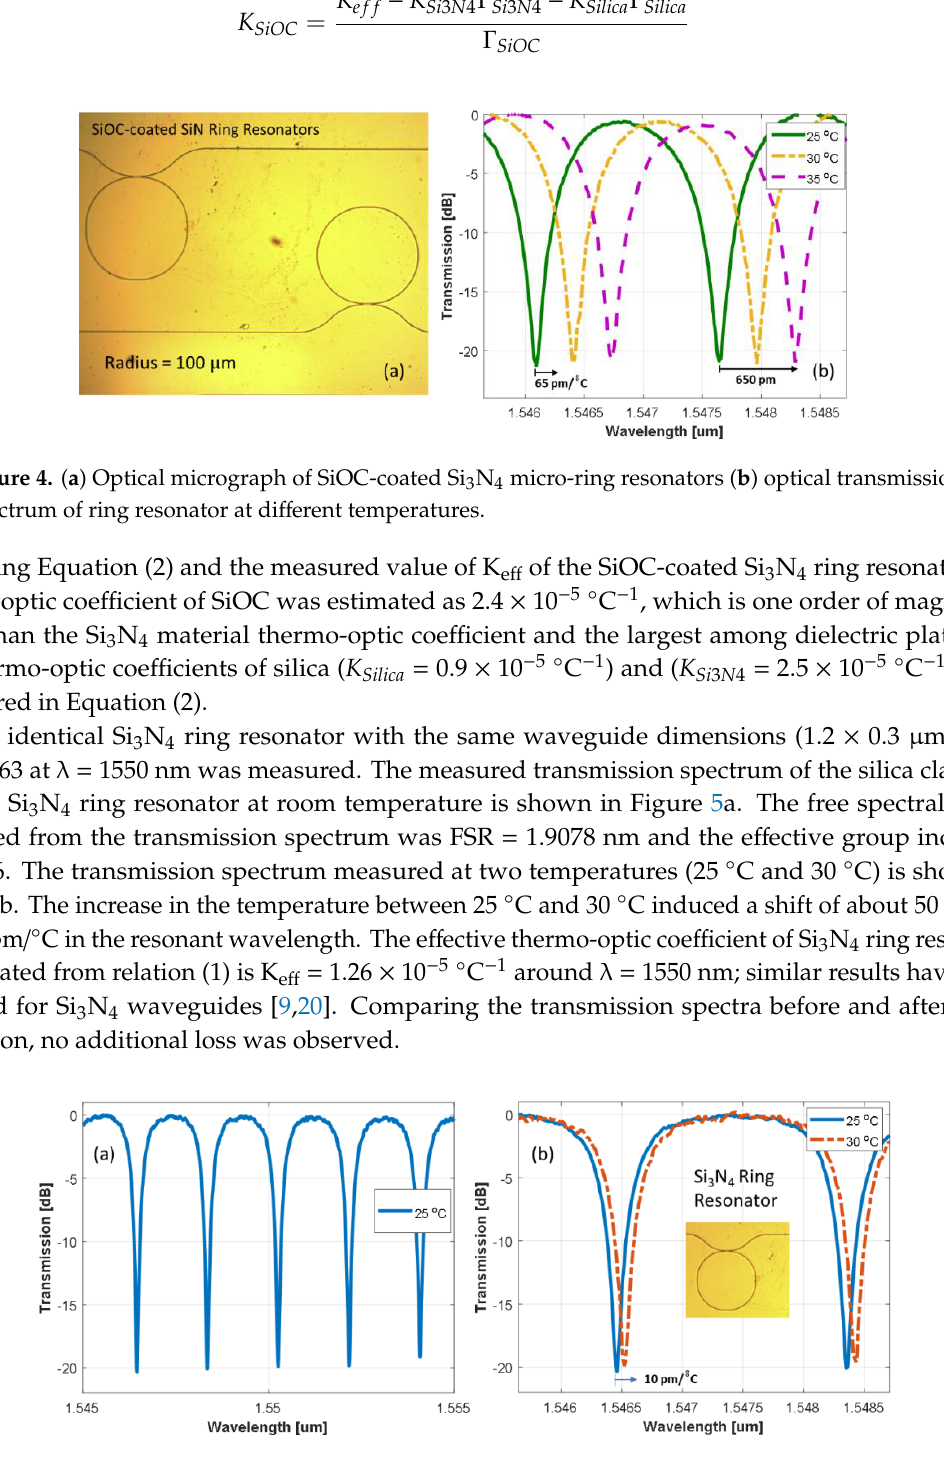
Figure 5. ( a ) Measured transmission spectrum of pristine Si 3 N 4 ring resonator ( b ) transmission spectrum of pristine Si 3 N 4 ring resonator at two different temperatures to estimate effective thermo-optic coefficient.